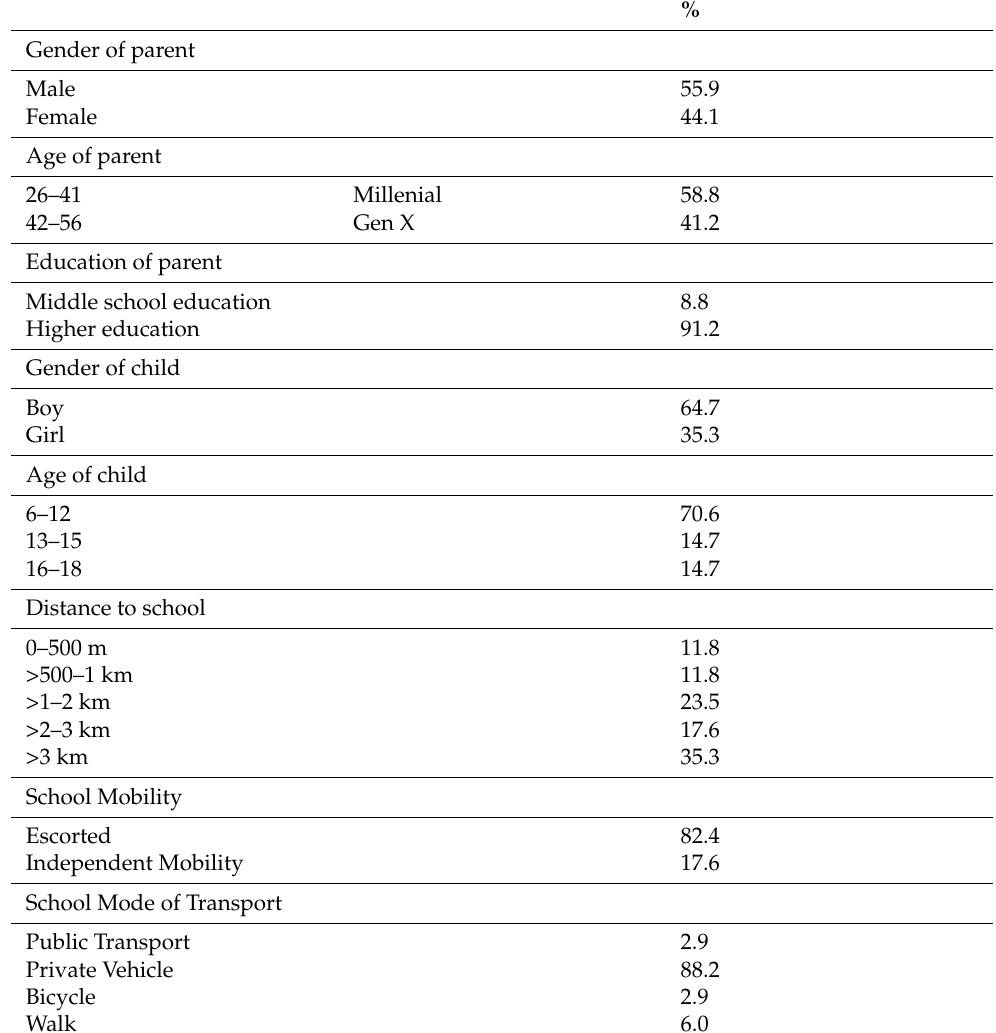
Table 1. Sociodemographic characteristics of participants ( n =